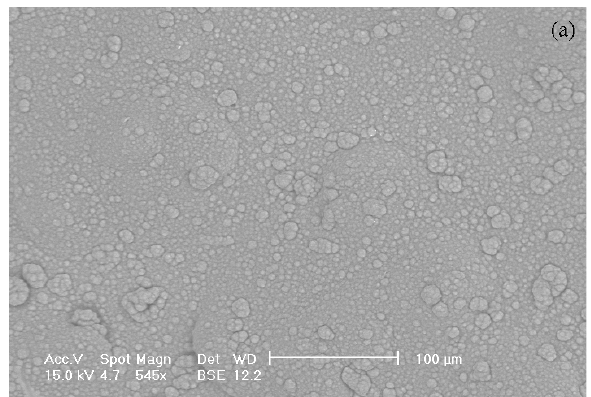
Figure 4a. Analysis of the RVC-PPy 0 electrode before Cd electrodepo- sition by scanning electron microscopy (SEM) using a backscattered electron image